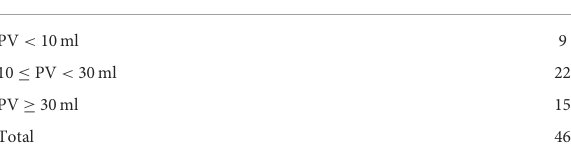
TABLE 4 The PSP volume of the control group. Pneumocephalus volume (PV)